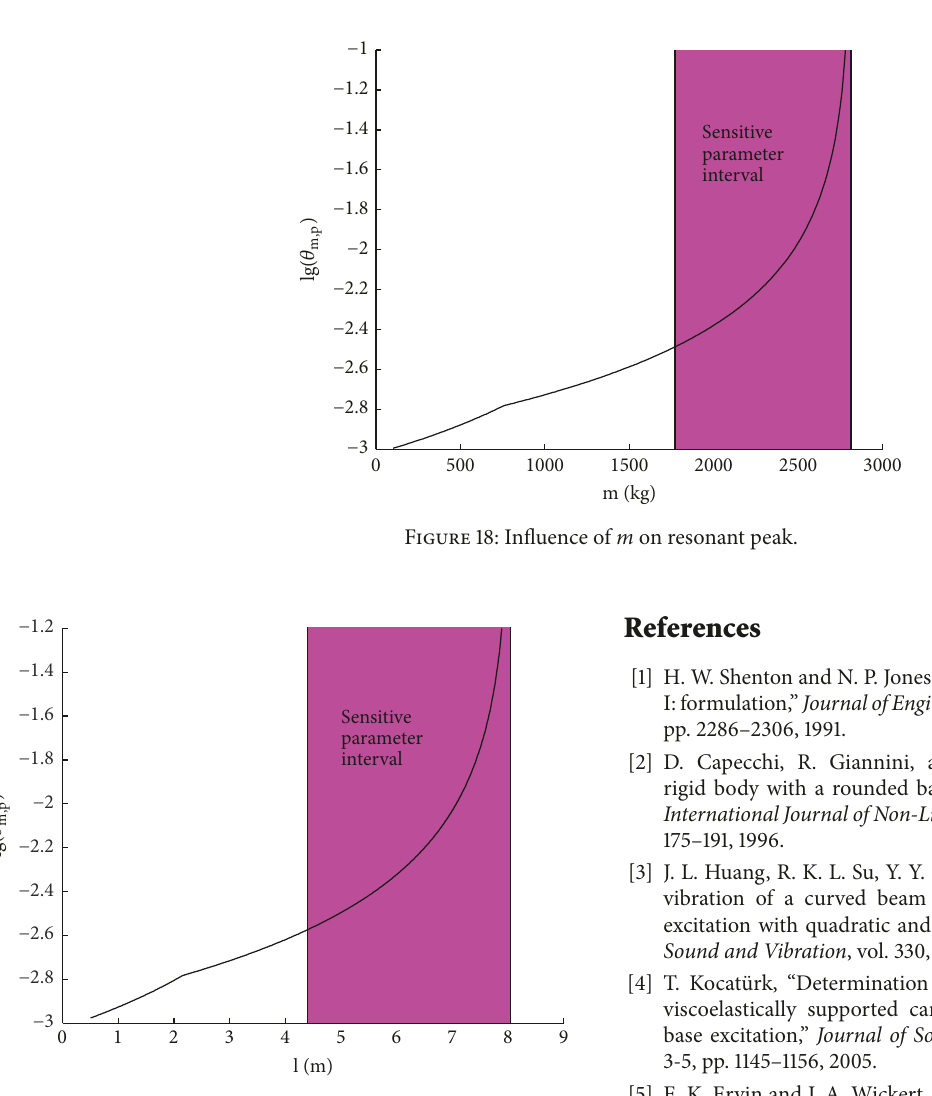
Figure 19: Influence of l on resonant